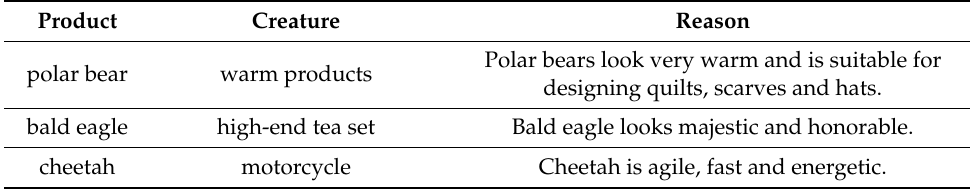
Table 7. Affective perception of creature—affective perception of product reasoning (58 times).